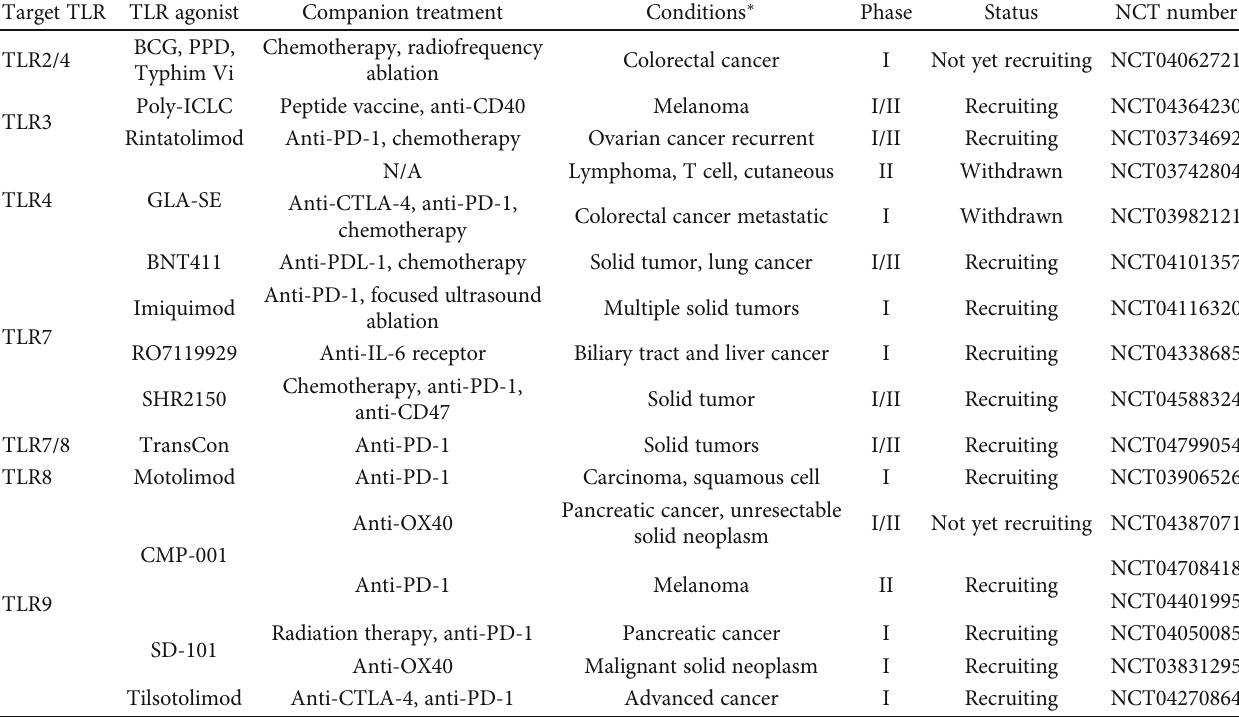
Table 3: A summary of recent ongoing clinical trials on TLR agonists started after 2019. Target TLR TLR